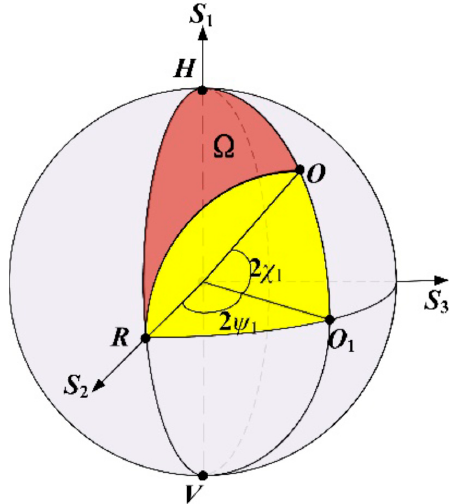
Figure 6. Theoretical model for estimating polarization state based on geometric phase (reprinted from Dou et al. [47]).